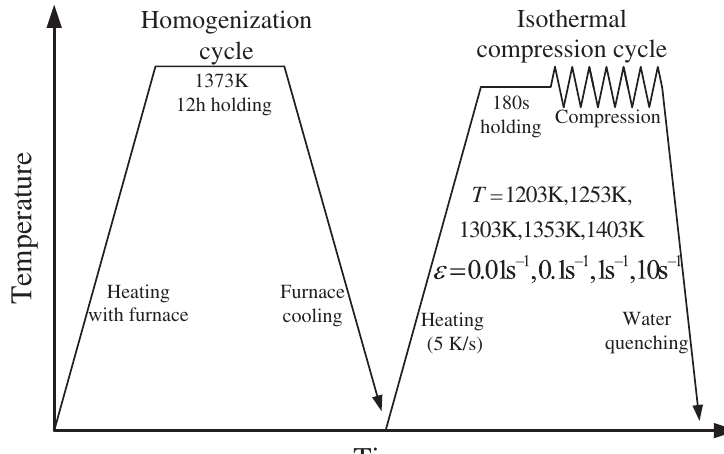
Figure 1: Experimental procedures for the isother- mal